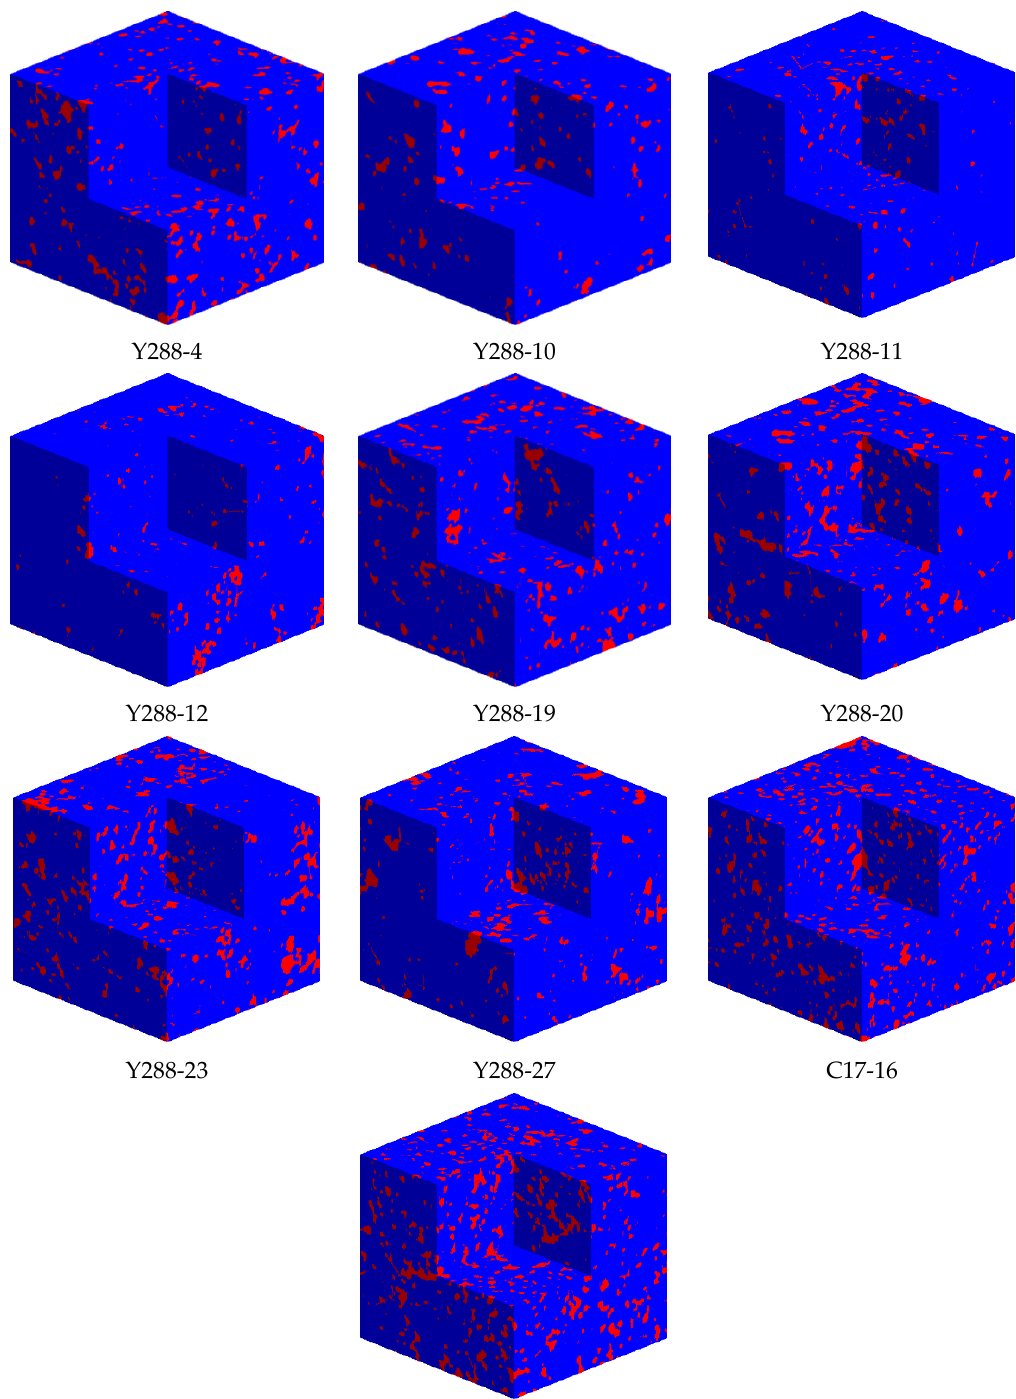
Figure 7. Construction of digital rock with complex pore structure. The comparison between digital rock with complex pore structure and experimental values are exhibited in Table 1. The value of the new method was obtained by superim- posing micro-pores on digital rock scanned by CT, and a small number of pores over- lapped in the three-dimensional space.